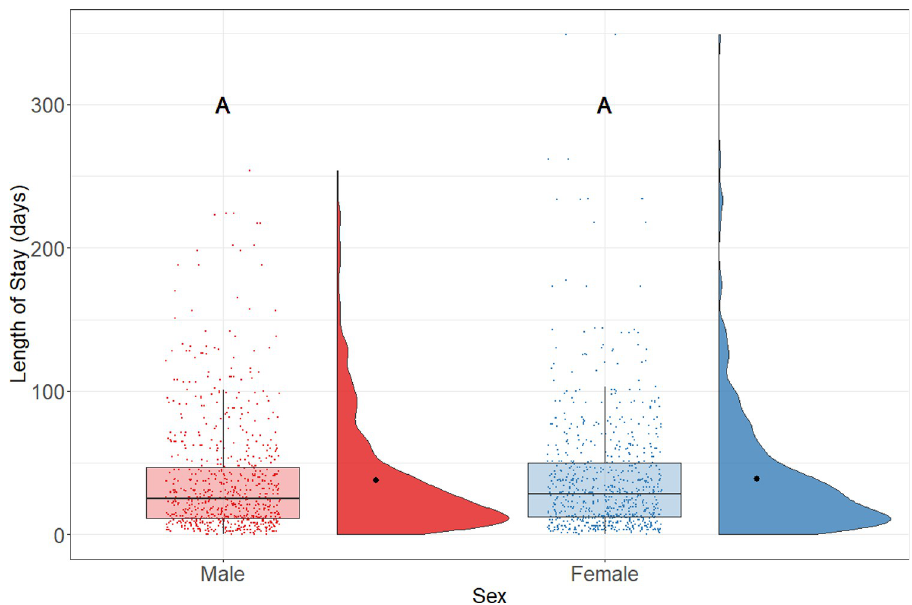
Fig 4. LOS of adopted rats by sex. Boxplots represent the median, the 25 and 75 percentiles, with whiskers representing the 95 percentiles. Individual data is shown by dots on the boxplot. Additionally, the rain cloud plots show the distribution and the means in each